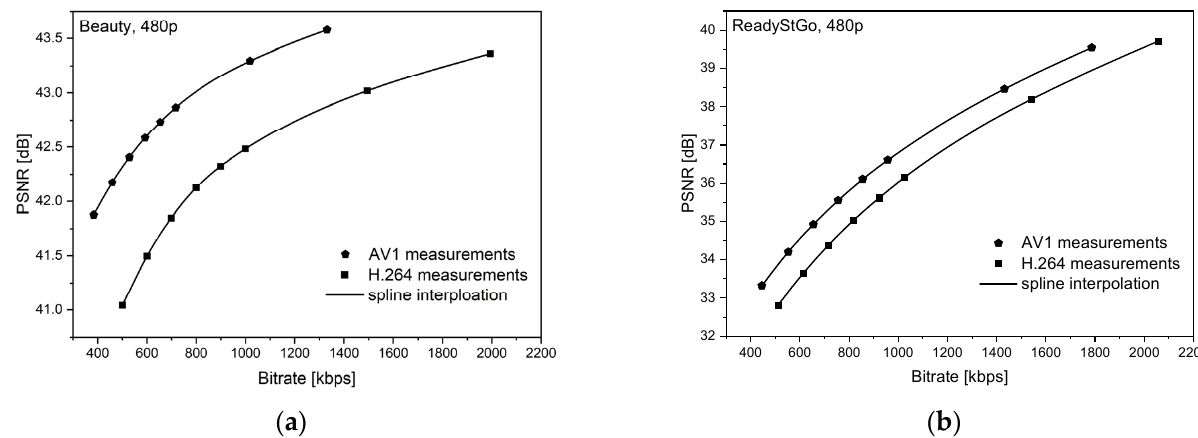
Figure 7. Comparison of the H.264 and AV1 codecs, based on the PSNR metric, for two different videos: ( a ) slow motion video; ( b ) fast motion video.